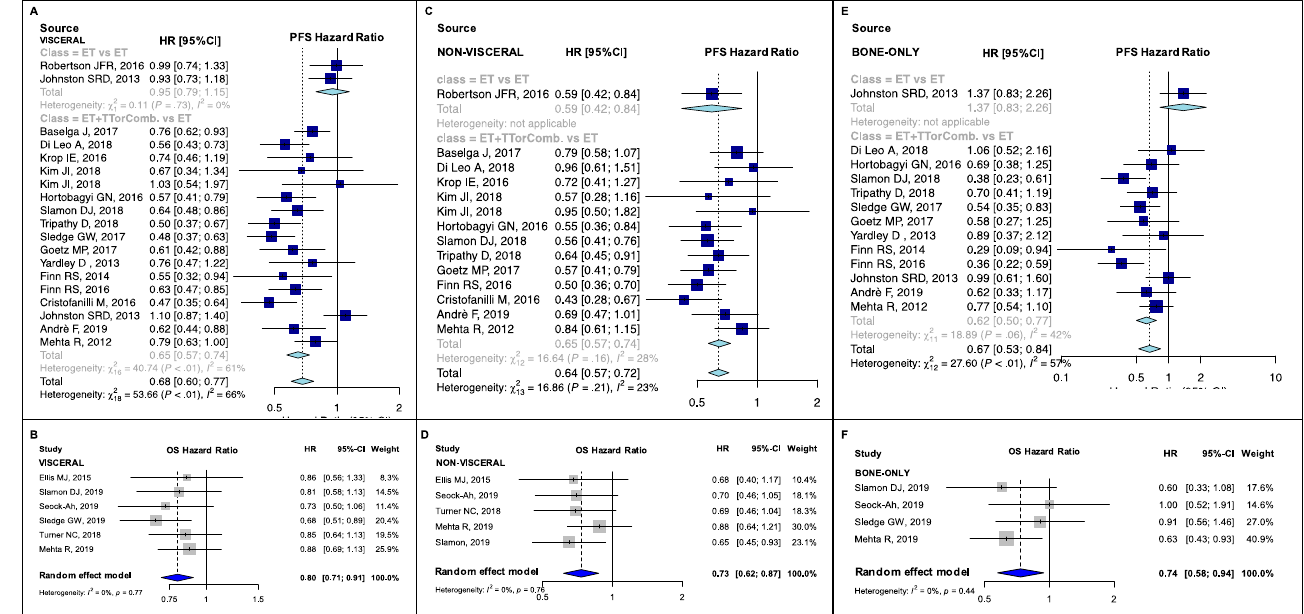
Figure 3. PFS and OS pooled results according to metastatic distribution: PFS pooled results for visceral ( A ), non-visceral ( C ) and bone-only disease ( E ) subgroups, overall and according to treatment strategy; and OS pooled results for visceral ( B ), non-visceral ( D ) and bone-only disease ( F ) subgroups. PFS, progression-free survival; OS, overall survival; ET vs. ET, studies comparing single endocrine agents therapies; ET + TT or Comb. vs. ET, studies comparing endocrine therapies + target therapies or endocrine therapies combinations against single agent endocrine treatments; HR, hazard ratio; 95% CI, 95% confidence interval.